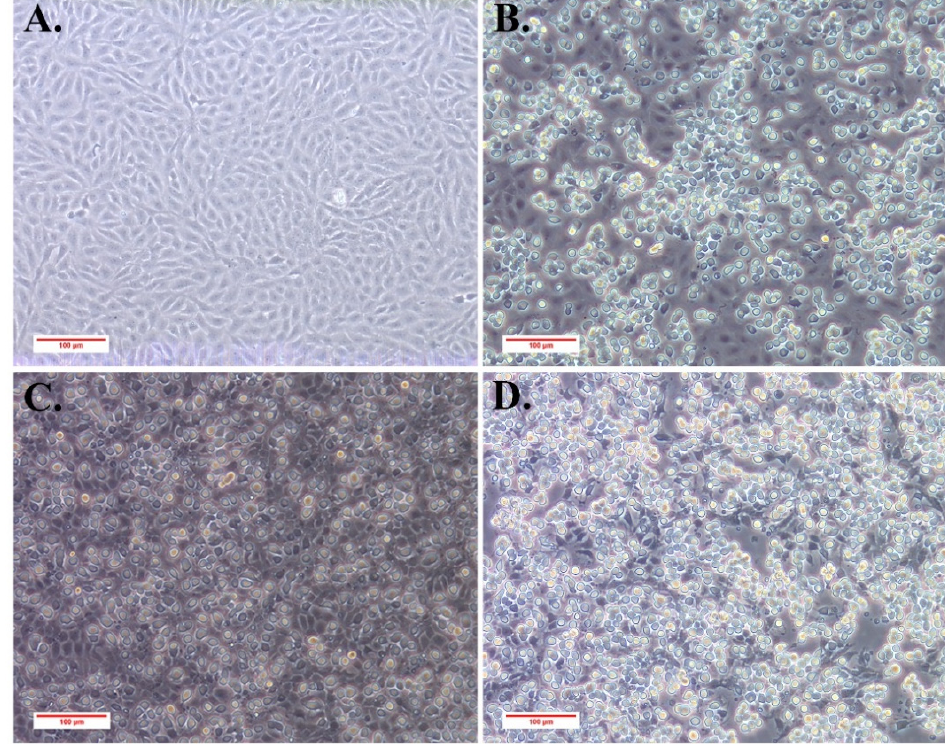
Figure 2. Replication of ZH ‐ 06/20 in MFF ‐ 1 cells. ( A ) Normal MFF ‐ 1 cells; ( B ) ascites ‐ inoculated MFF ‐ 1 cells on day 6 post ‐ inoculation; (C/D) ZH ‐ 06/20 at passage 2 ( C ) and passage 7 ( D ) in MFF ‐ 1 cells at 2 days post ‐ infection.